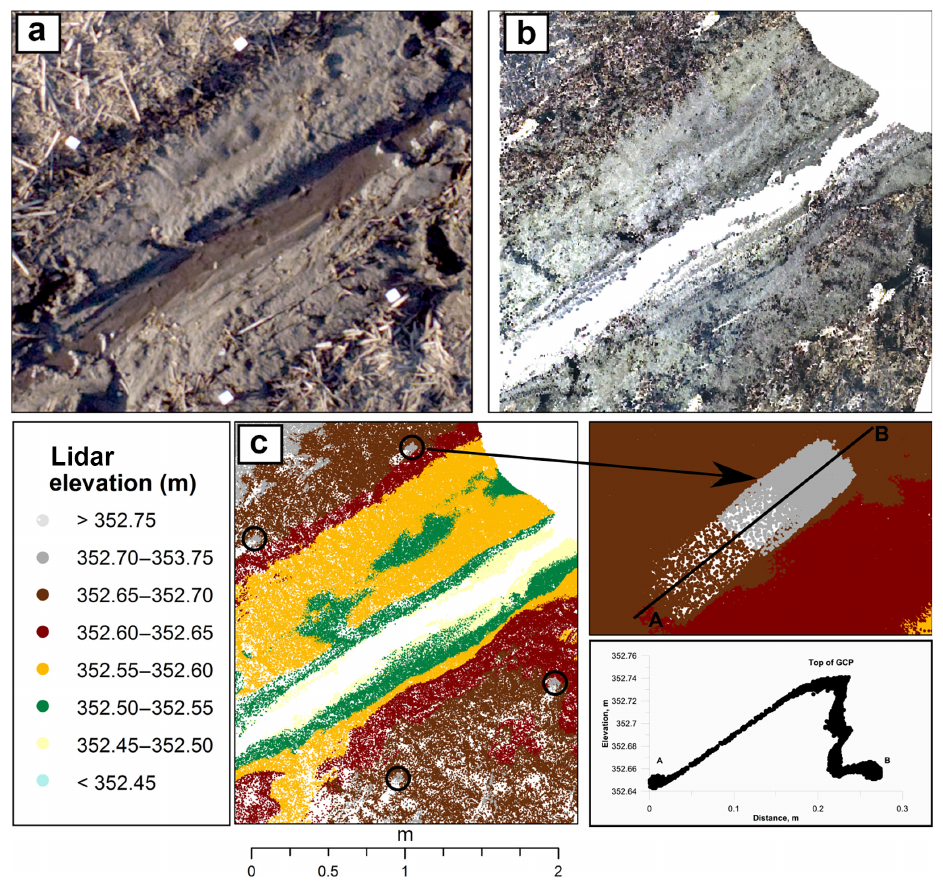
Figure 3. Limitations of the terrestrial lidar survey used herein as a reference dataset. (a) Photograph of AOI showing water in the channel, which limits laser pulse return to the sensor, causing sampling gaps in the point cloud (b) . The presence of high relief features (GCPs) in the DEM (c) with sharp edges that cause the generation of multiple laser pulse returns due to the split footprint